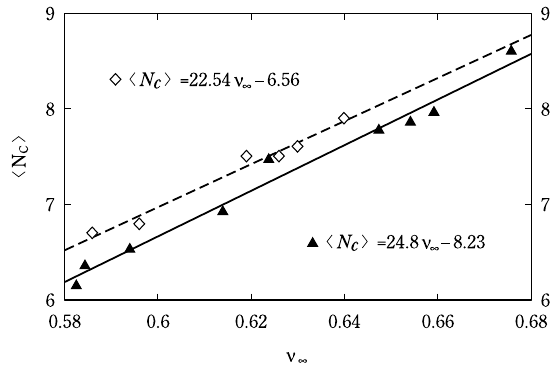
Fig. 9 Behavior of the equilibrium solids fraction ν ∞ obtained from the fit of the data to the hyperbolic tangent model ( ν (n; γ ) ＝